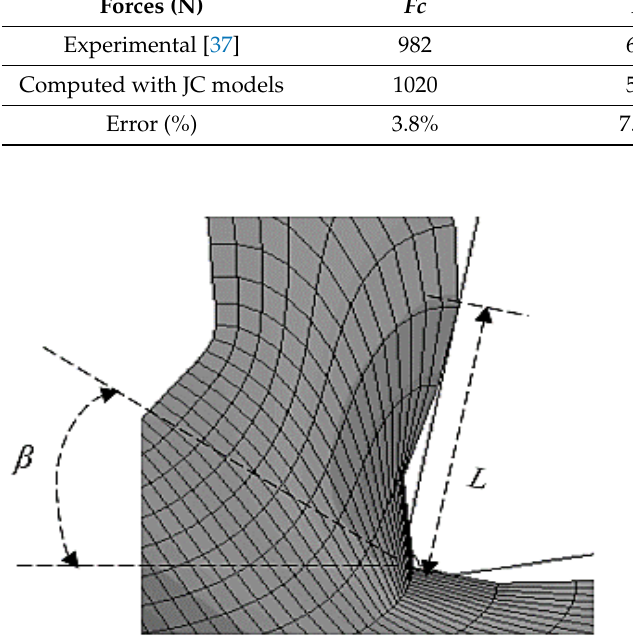
Figure 17. Total chip contact length L and angle of shear β . Table 10 resumes the numerical and the experimental results of cutting forces. Table 10. Numerical and experimental cutting forces, Vc = 50m/min. Table 11. Chip geometries, Vc = 50